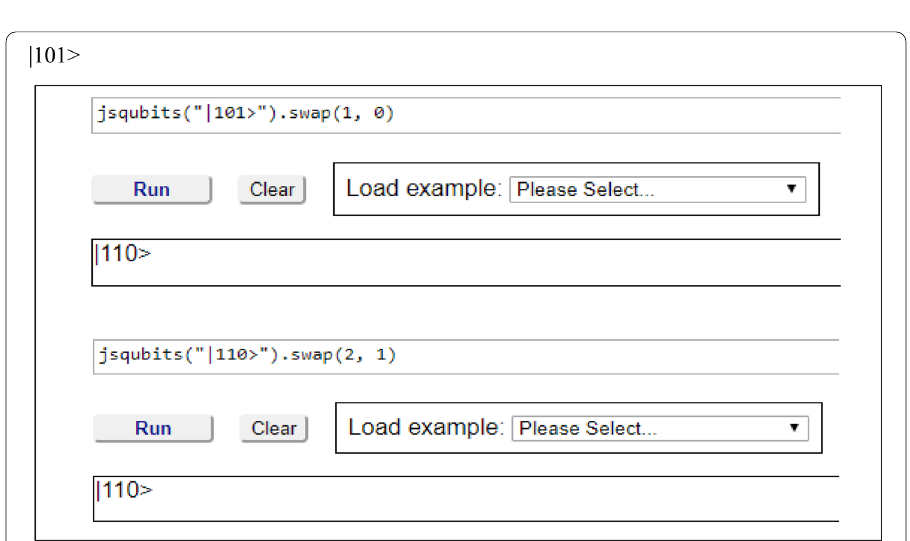
Fig. 21 Rotating quantum bit string |101 > by using a swap